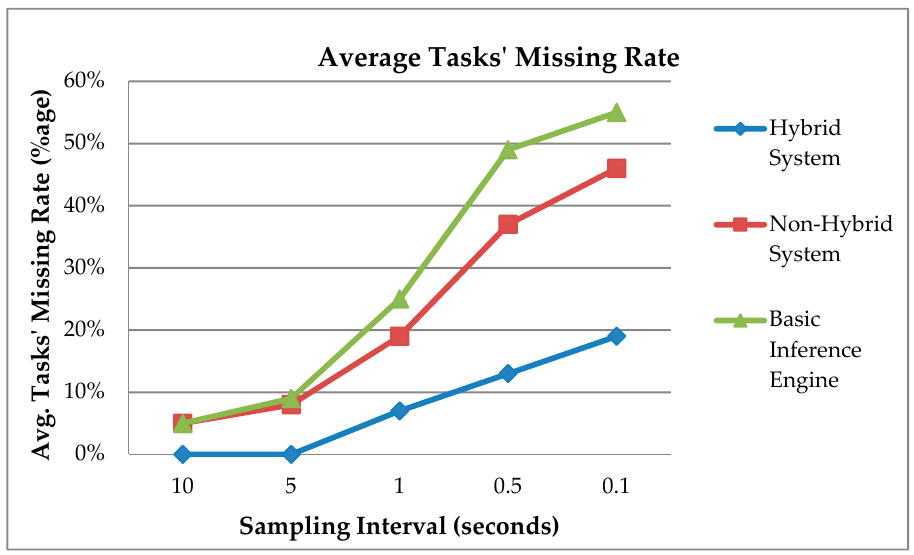
Figure 14. Average tasks missing rate.